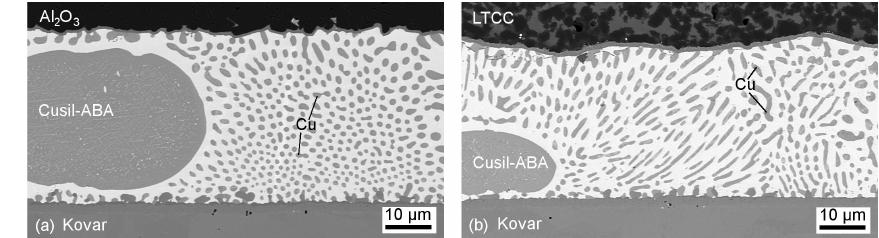
Figure 10. SEM images of Kovar–Al 2 O 3 (a) and Kovar–LTCC (b) joints brazed with Cusil-ABA at 830 ◦ C for 10min.